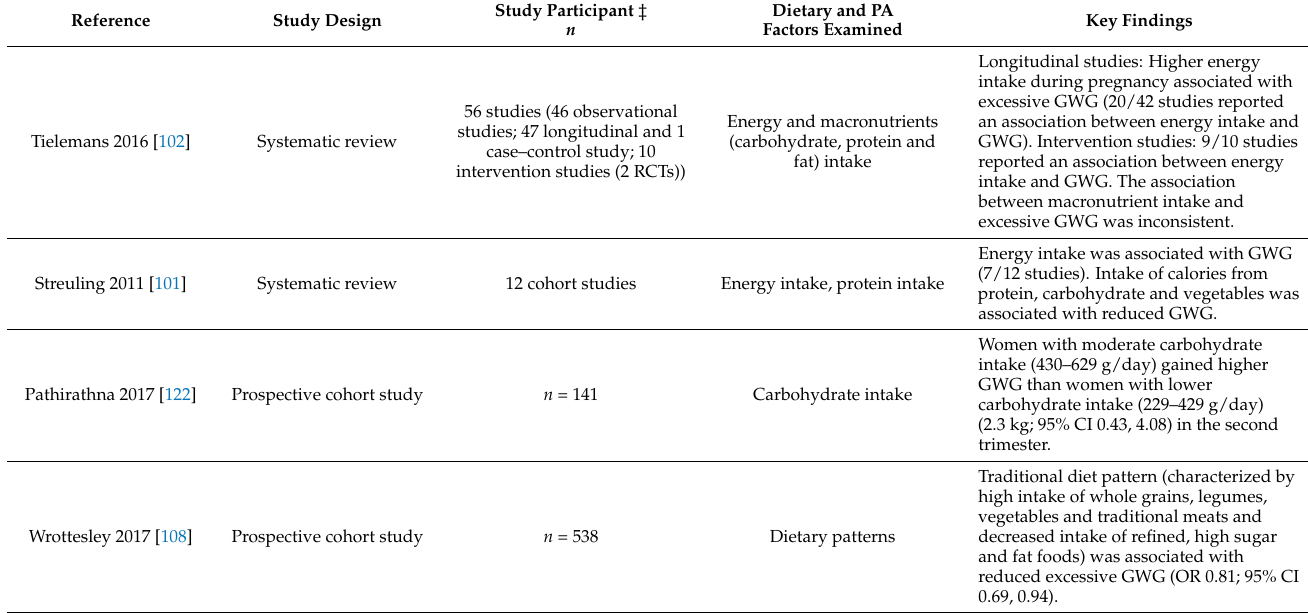
Table 2. Summary of studies assessed diet, physical activity and weight gain during